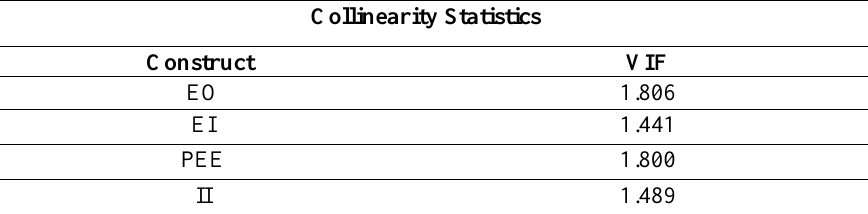
Table 04: Results of multicollinearity